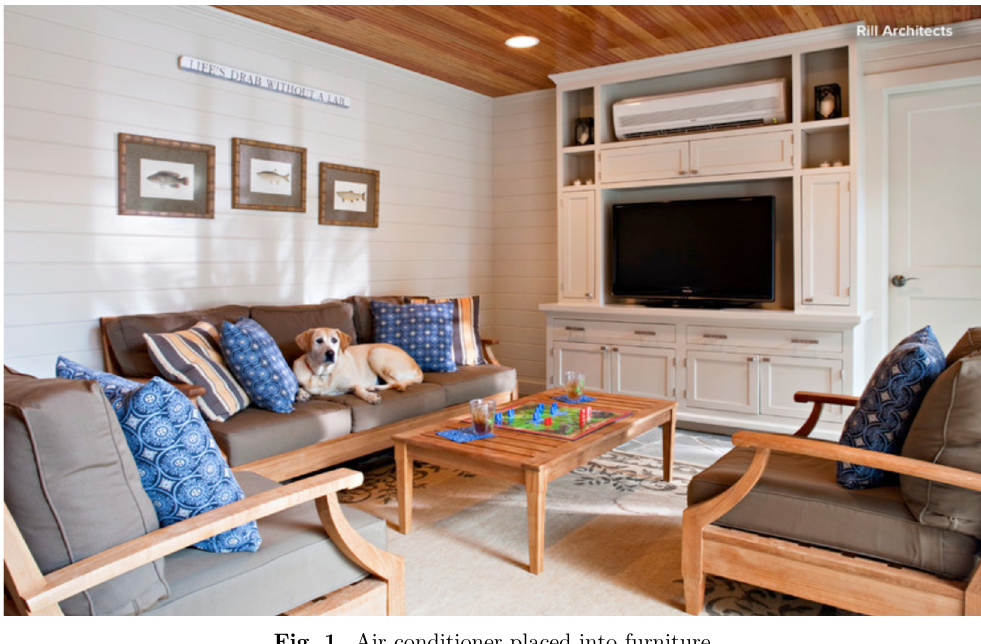
Fig. 1. Air conditioner placed into